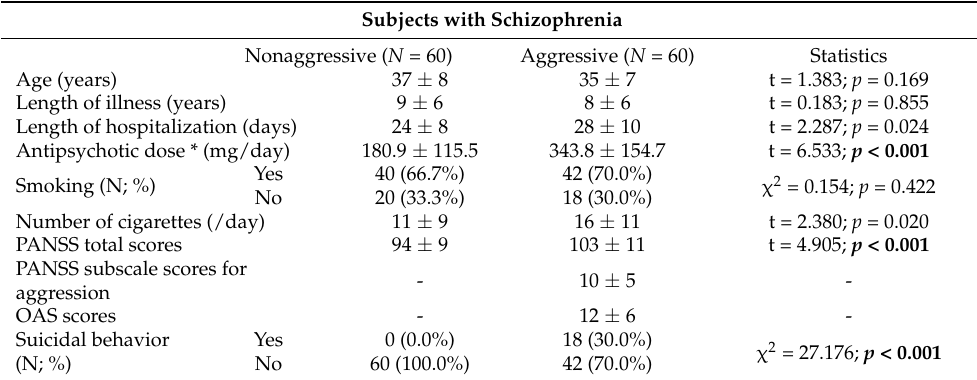
Table 1. Demographic and psychometric data in female subjects with schizophrenia divided into nonaggressive and aggressive subjects. Subjects with Schizophrenia Nonaggressive ( N = 60) Aggressive ( N = 60) Statistics Age (years) 37 ± 8 35 ±